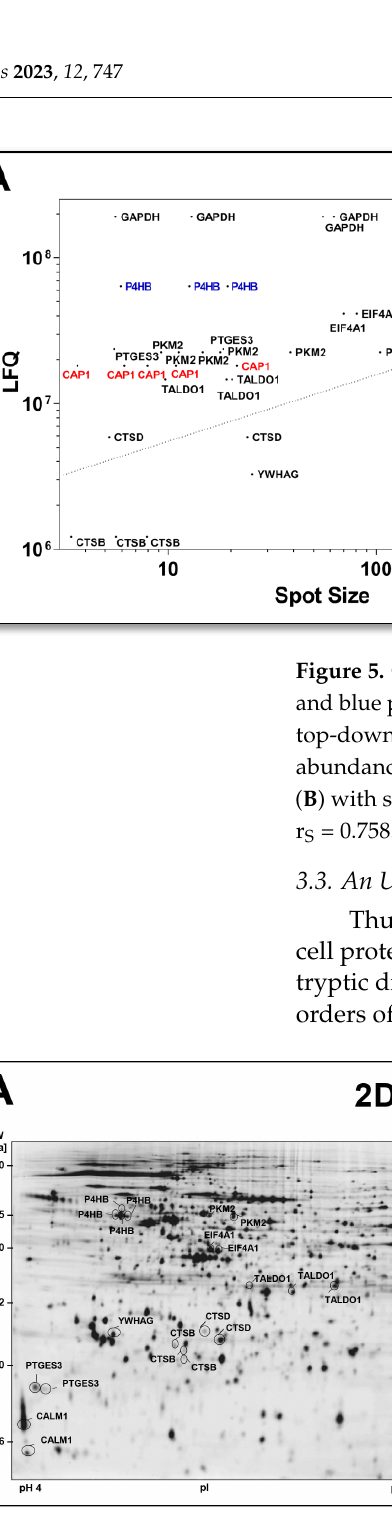
Figure 6. Proteomes at a glance. ( A ) Representative analytical 2D-DIGE gel. Circled protein spots were chosen for proteoform analysis (Table 1). ( B ) Representative heatmap of peptides separated by retention time and mass-to-charge. Centroid-peak view of all identified peptides, red marks at retention time, and m / z axis indicate peptides assigned to an individual protein (i.e., PKM). Abbreviations: 2D-DIGE—two-dimensional difference gel electrophoresis; MW—molecular weight; pI—isoelectric